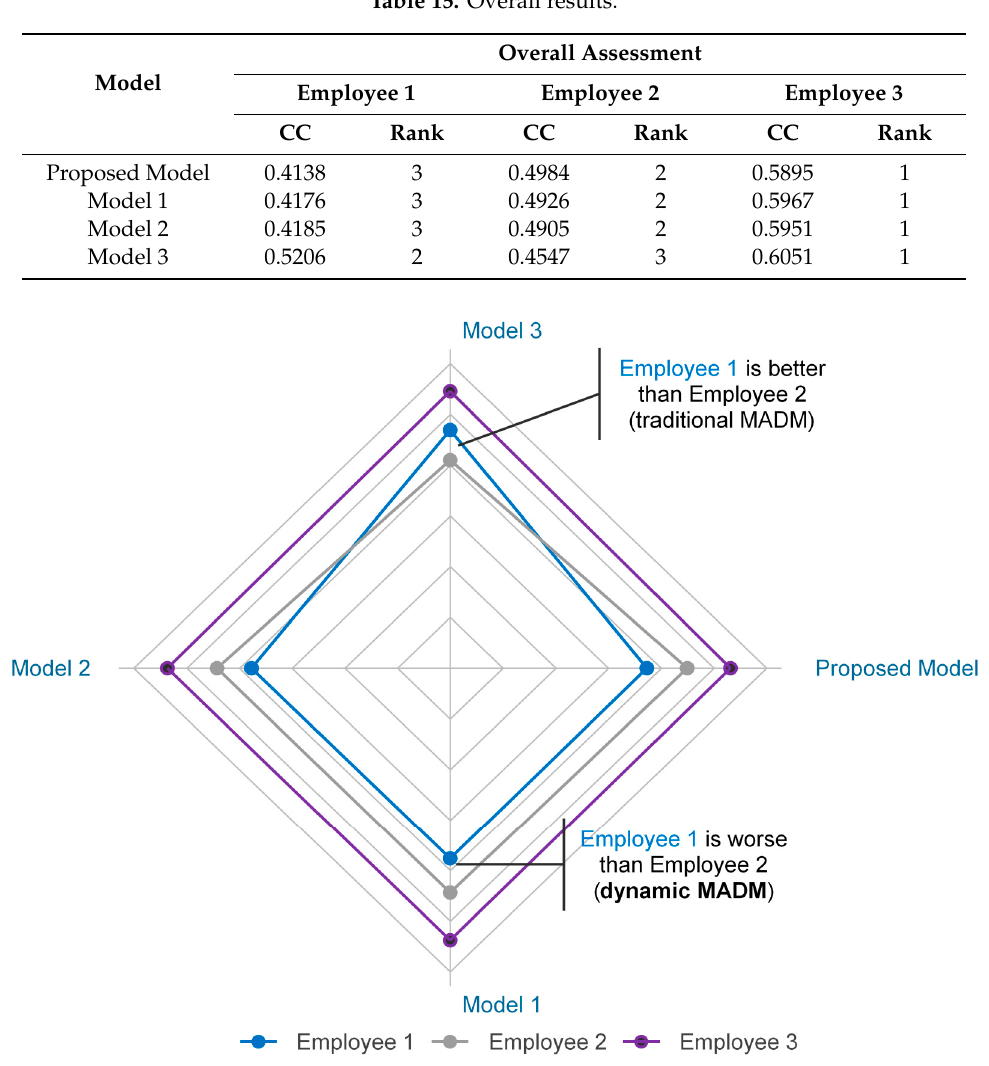
Figure 9. Changes in the ranking of employee 1.